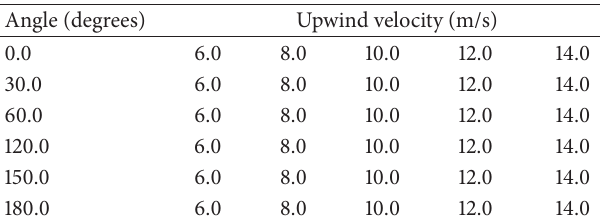
Table 3: Number of cells in million for the used